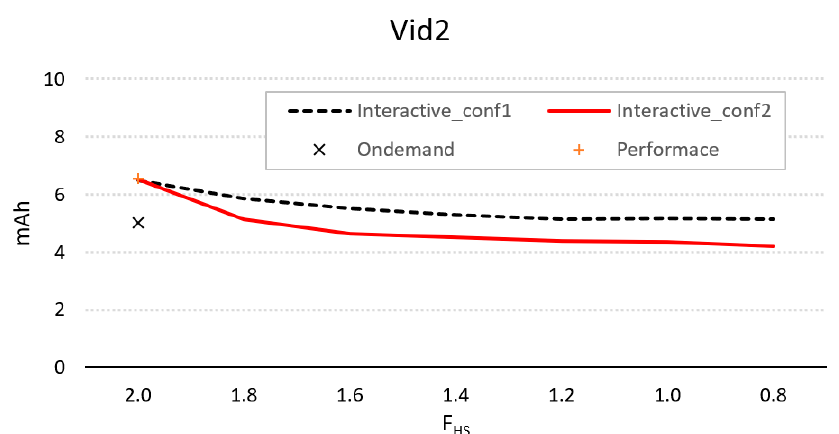
Figure 6. Evolution of energy consumption for the interactive controller for configurations 1 and 2, using different values of F hs , compared to consumption using Ondemand and Performance.